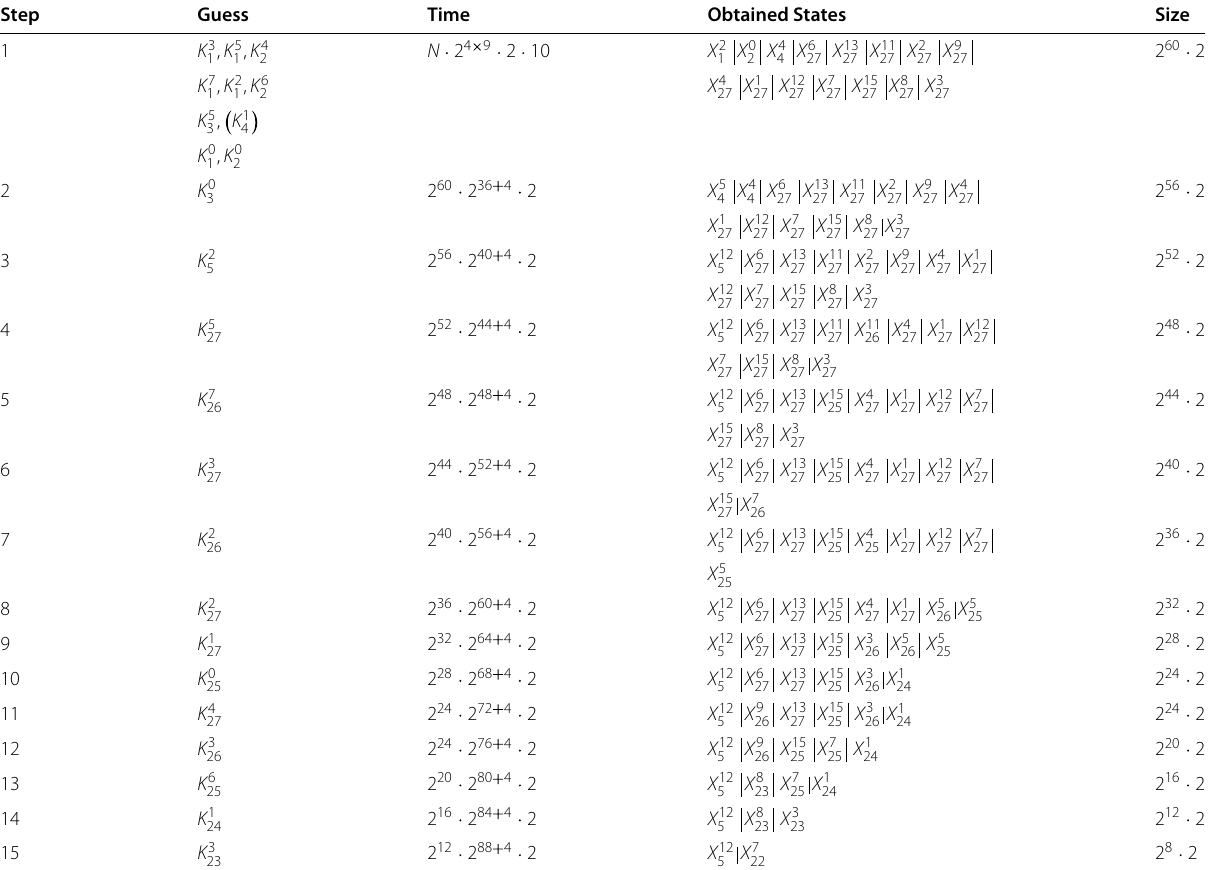
Table 7 Partial encryption and decryption on 27-round TWINE-128 Step Guess Time Obtained States